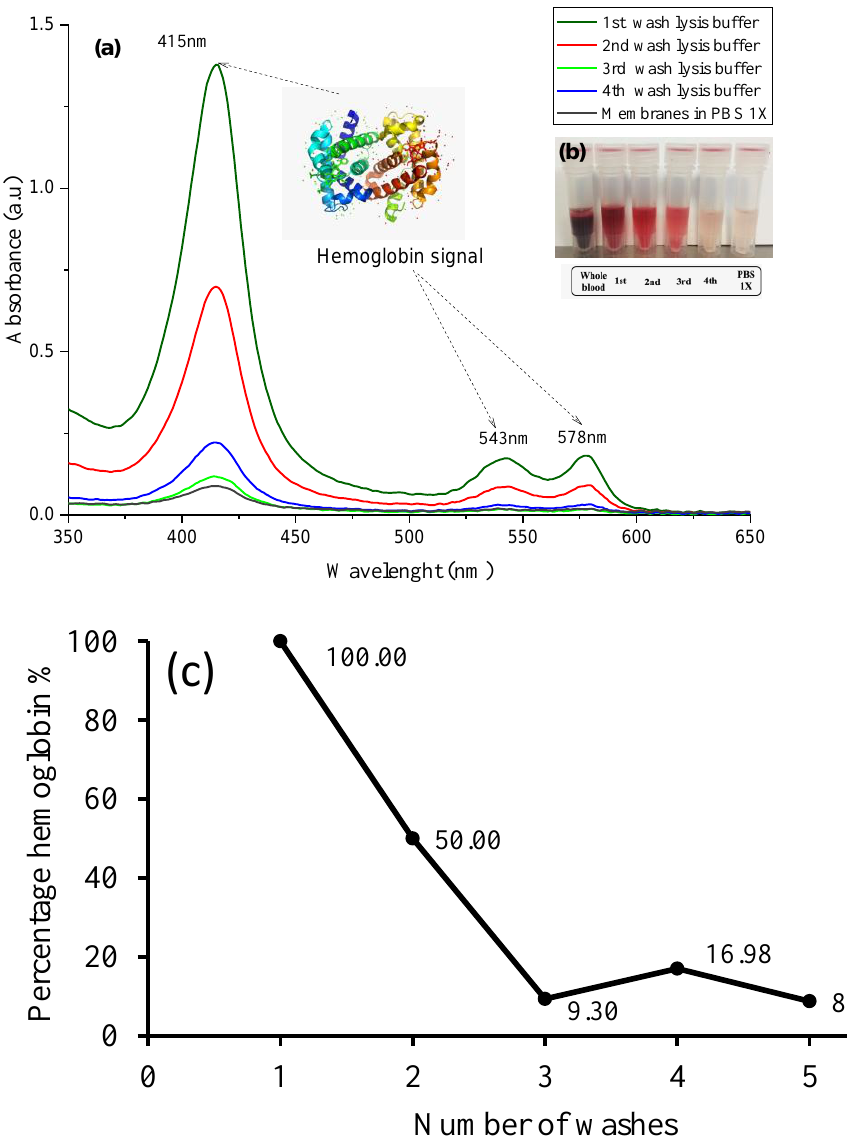
Figure 12. ( a ) UV-Vis absorption graph of the hemoglobin protein spectrum, ( b ) color variation and ( c ) hemoglobin concentration for each wash.